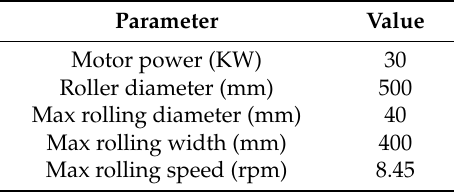
Figure 2. H500 mill. Table 1. The main technical parameters of H500.